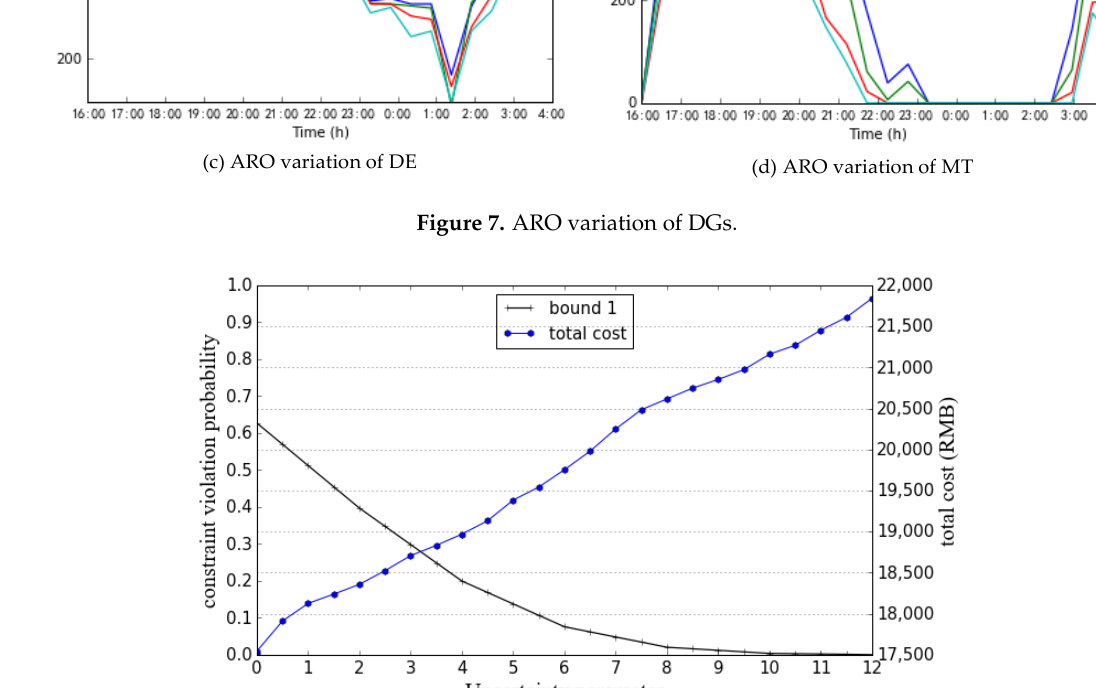
Figure 7. ARO variation of DGs.